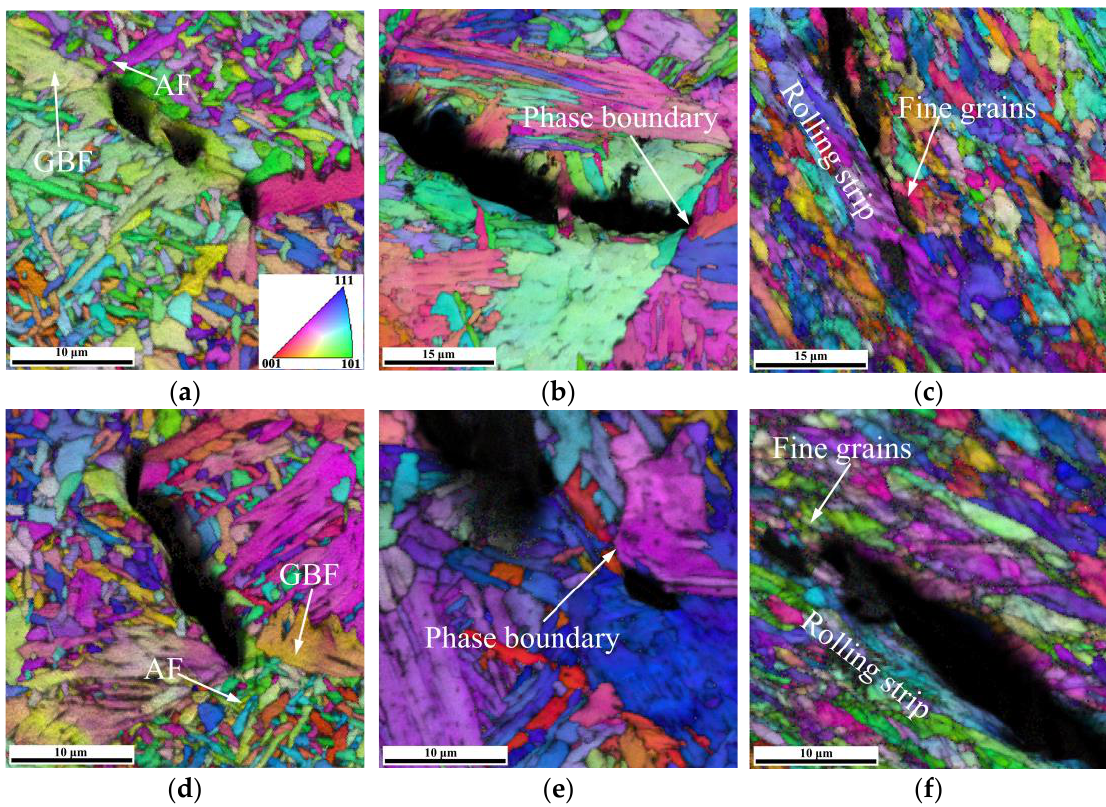
Figure 9. EBSD maps of secondary cracks in the H 2 S-containing environment: ( a ) WM, ( b ) CGHAZ, ( c ) SCHAZ; EBSD maps of secondary cracks in air environment: ( d ) WM, ( e ) CGHAZ, ( f ) SCHAZ.